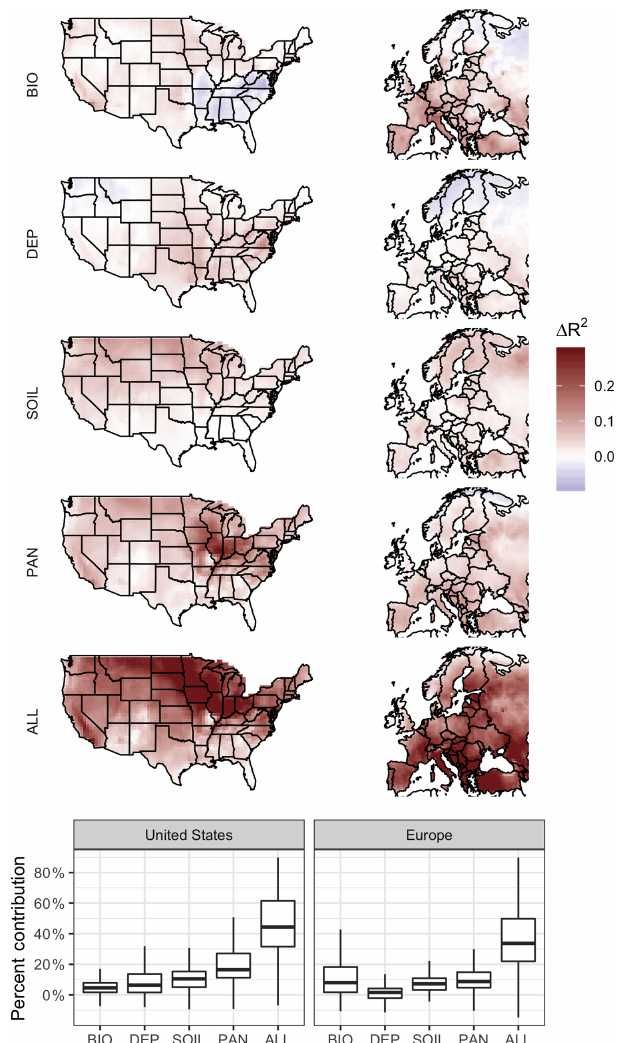
Figure 5. Impact of temperature dependence of biogenic emissions, O 3 dry deposition, soil NO x emissions, PAN lifetime, and all mech- anisms at once. Plotted values show the difference between O 3 – temperature correlation in the BASE case and that of the modified case in which dependence on daily temperature variability is re- moved.